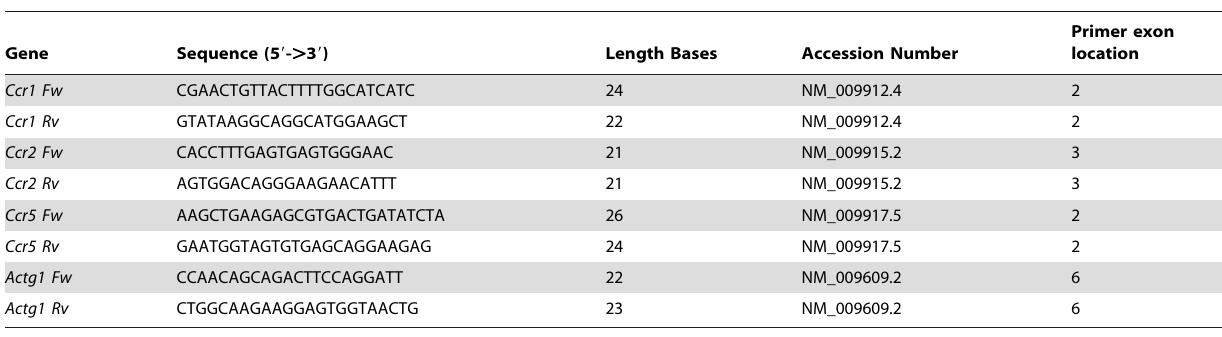
Table 1. Primer sequences used in RT-PCR.